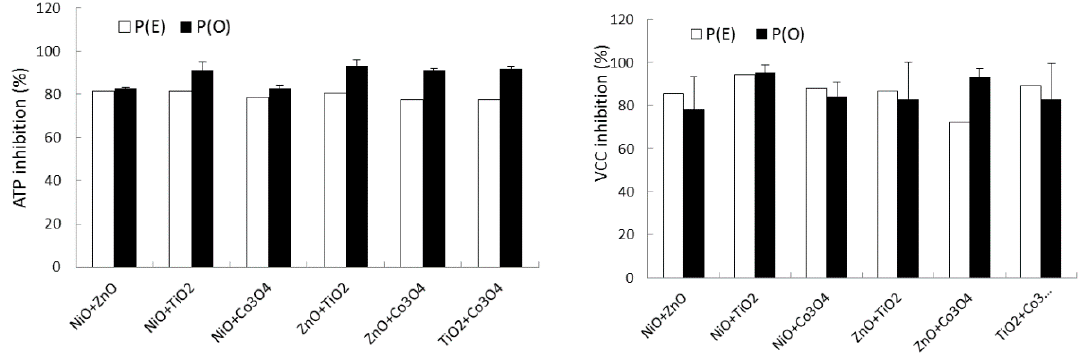
Figure 3. Comparisons of P(O) and P(E) for binary NP mixtures based on ATP content and VCC.